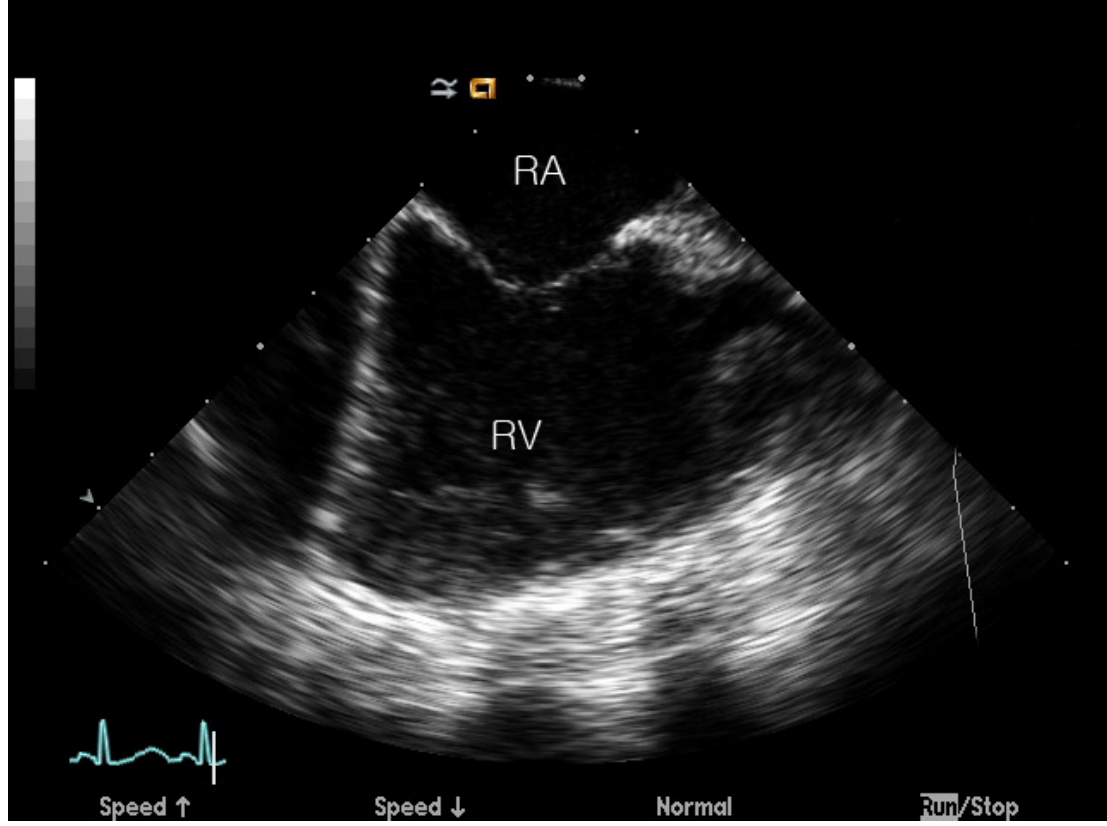
Figure 1. “Home view” of intracardiac echocardiography. RA: right atrium, RV: right ventricle. “Home view” was obtained to analyze the vector velocity image of the right ventricle, before and after the transcatheter closure.